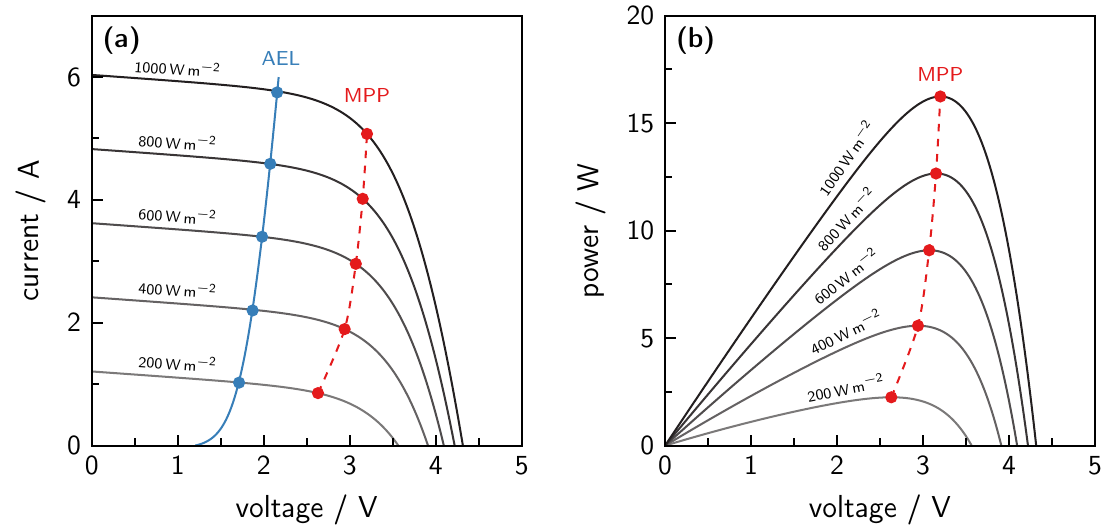
Figure 9. Example calculation results of the ( a ) current–voltage characteristics of a photovoltaic panel at different solar radiation levels and the corresponding ( b ) power–voltage curve.